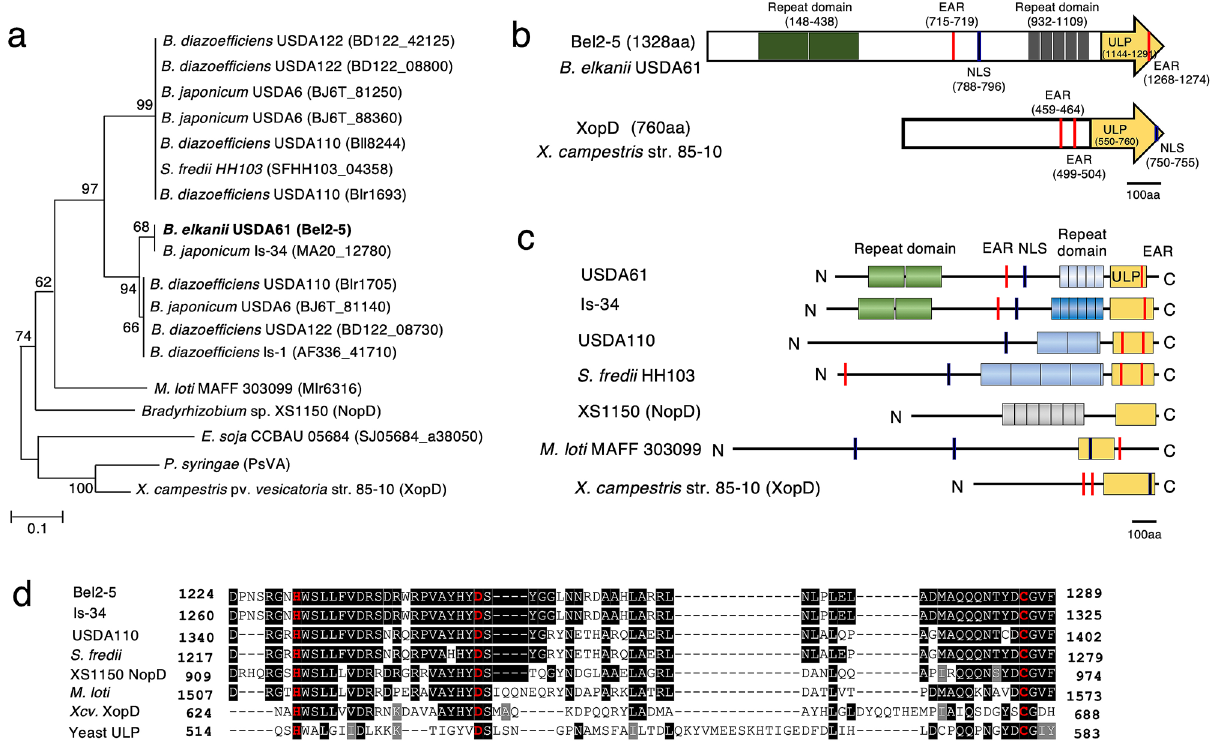
Figure 2. Phylogenetic and In silico analyses of B. elkanii Bel2-5 and its homologs. ( a ) Neighbor-joining tree of Bel2-5 and its homologs in T3SS-harbouring rhizobia and phytopathogenic bacteria. Boostrap values are given at the nodes with boostrap resampling (1000 replicates of each). ( b ) Schematic representation of Bel2-5 and XopD from X. campestris str. 85–10. ( c ) Schematic representation of Bel2-5 functional domains in B. elkanii USDA61, in comparison to its homologs in selected rhizobia and pathogenic bacteria. The repeat domain I and II, EAR motifs, NLS motif and ULP1 domain are shown. ( d ) Sequence alignment of ULP1 catalytic domain of B. elkanii BEL2-5 and its selected homologs, including: B. japonicum Is-34 (MA20_12780), B. diazoefficiens USDA110 (Bll8244), S. fredii HH103 (SFHH103_04358), Bradyrhizobium sp. XS1150 (NopD), M. loti MAFF 303,099 (Mlr6316), X. campestris pv. vesicatoria str. 85–10 (XopD), and yeast ULP1 (DAA11408.1). H, D and C catalytic core residues are indicated by red. Identical amino acids are shaded in black, and similar amino acids are shaded in gray,